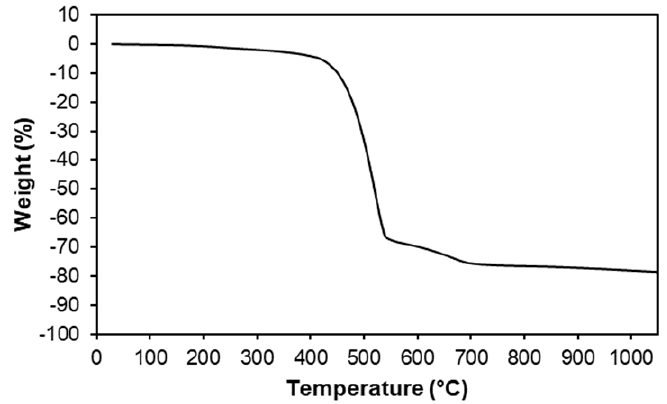
Figure 2. X-ray crystallography data. ( a ) ORTEP (Oak Ridge Thermal- Ellipsoid Plot Program) diagram of 3 in perspective view. Ellipsoids are drawn at the 30% probability level. Hydrogen atoms are omitted for clarity. Black: carbon; blue: silicon; red: oxygen; green: chlorine. ( b ) Side view of 3 with number labels. Hydrogen atoms and phenyl rings are omitted for clarity. Yellow: silicon; red: oxygen.